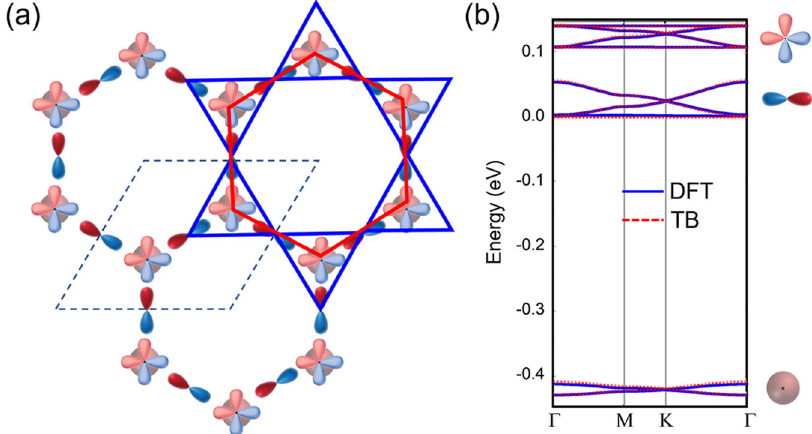
Fig. 4 A p -orbital tight-binding model of the HKL lattice. a The HKL with p -orbital on Kagome lattice (in blue) and s, p x , p y orbitals on honeycomb lattice (in red). b TB and DFT band structures. From the bottom up: the bands are constructed with HAT- s , Fe-DPyP- p , and HAT- p x / p y basis,